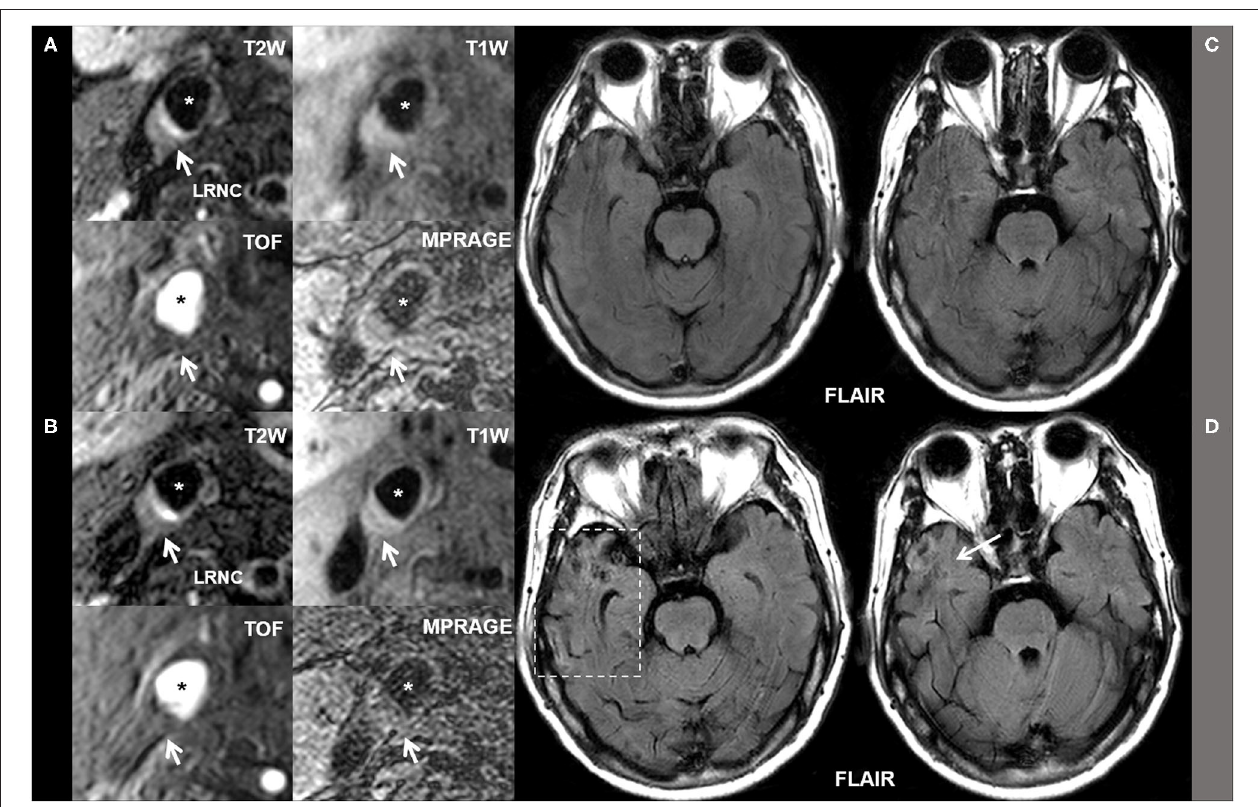
FIGURE 2 | The baseline (A,C) and follow-up (B,D) MR images of a patient who had LRNC plaque in the right carotid with co-existing hypertension and H-Hcy (25 µ mol/L). The LRNC (white arrows on T1W, T2W, TOF, and MP-RAGE images) in the right carotid artery and ipsilateral subsequent ischemic stroke (white arrows on Flair images) in the temporal lobe had progressed after 1-year follow-up. * Marks lumen of common carotid